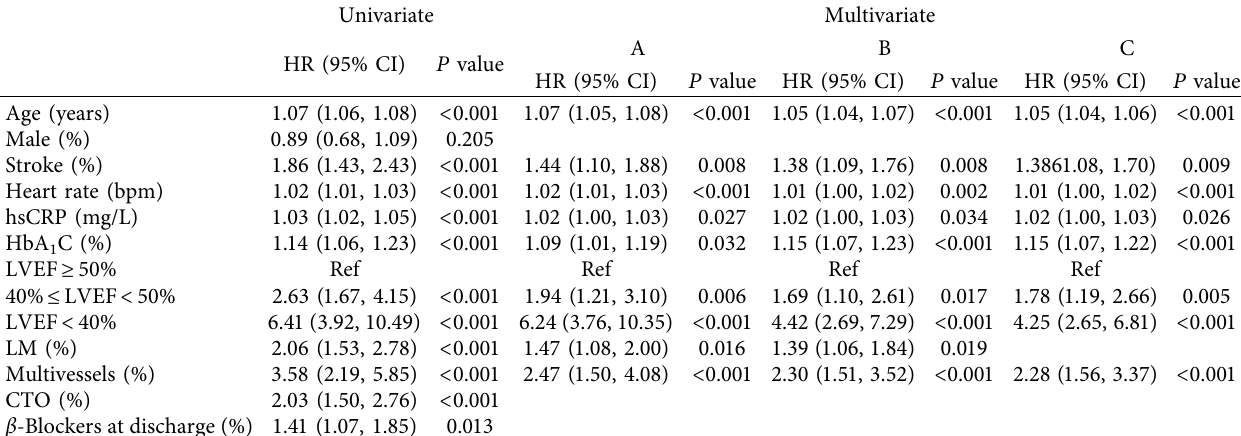
Figure 4: Kaplan-Meier curve for secondary endpoints before (a, b, c) and after (d, e, f) propensity score matching patients in the β -blocker and the no -blocker group. β Table 5: Multivariate Cox regression analysis of secondary